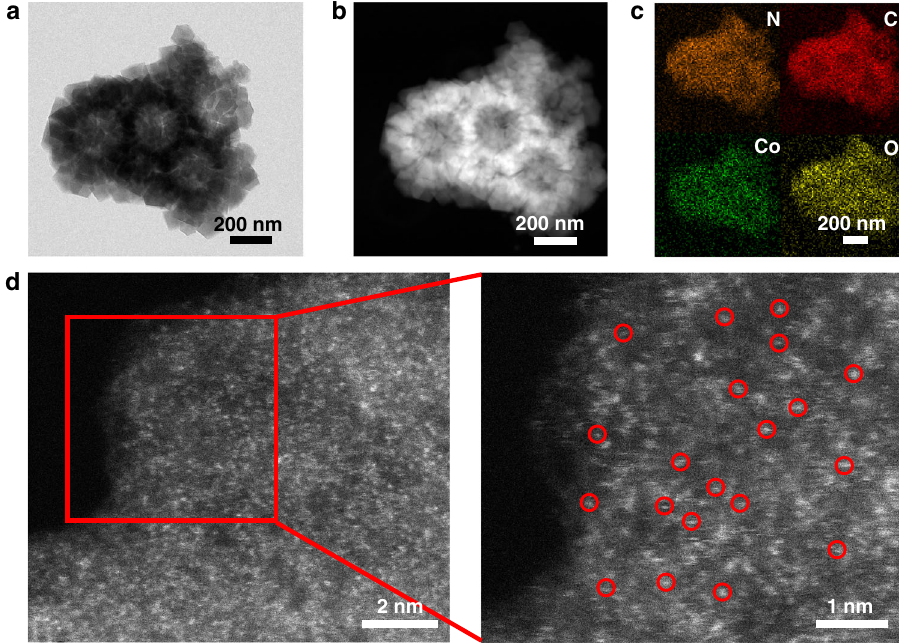
Fig. 2 Representative electron microscopy images. a TEM image, b HAADF image, c STEM element mapping images, d aberration-corrected HAADF- STEM and magni fi ed images of Co SA